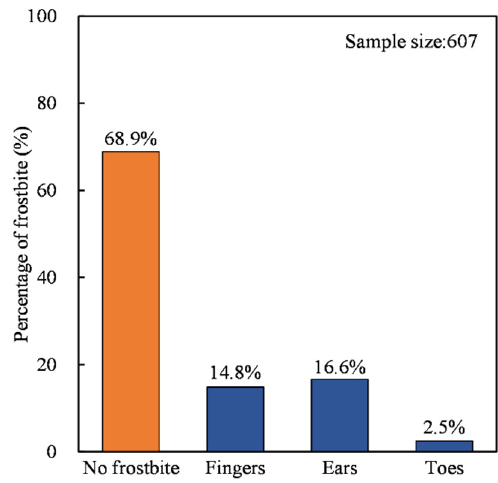
Figure 12. Proportion of frostbite among the subjects by body part. Table 7. IREQ, ICL, and DLE corresponding to light-, moderate-, and vigorous-intensity